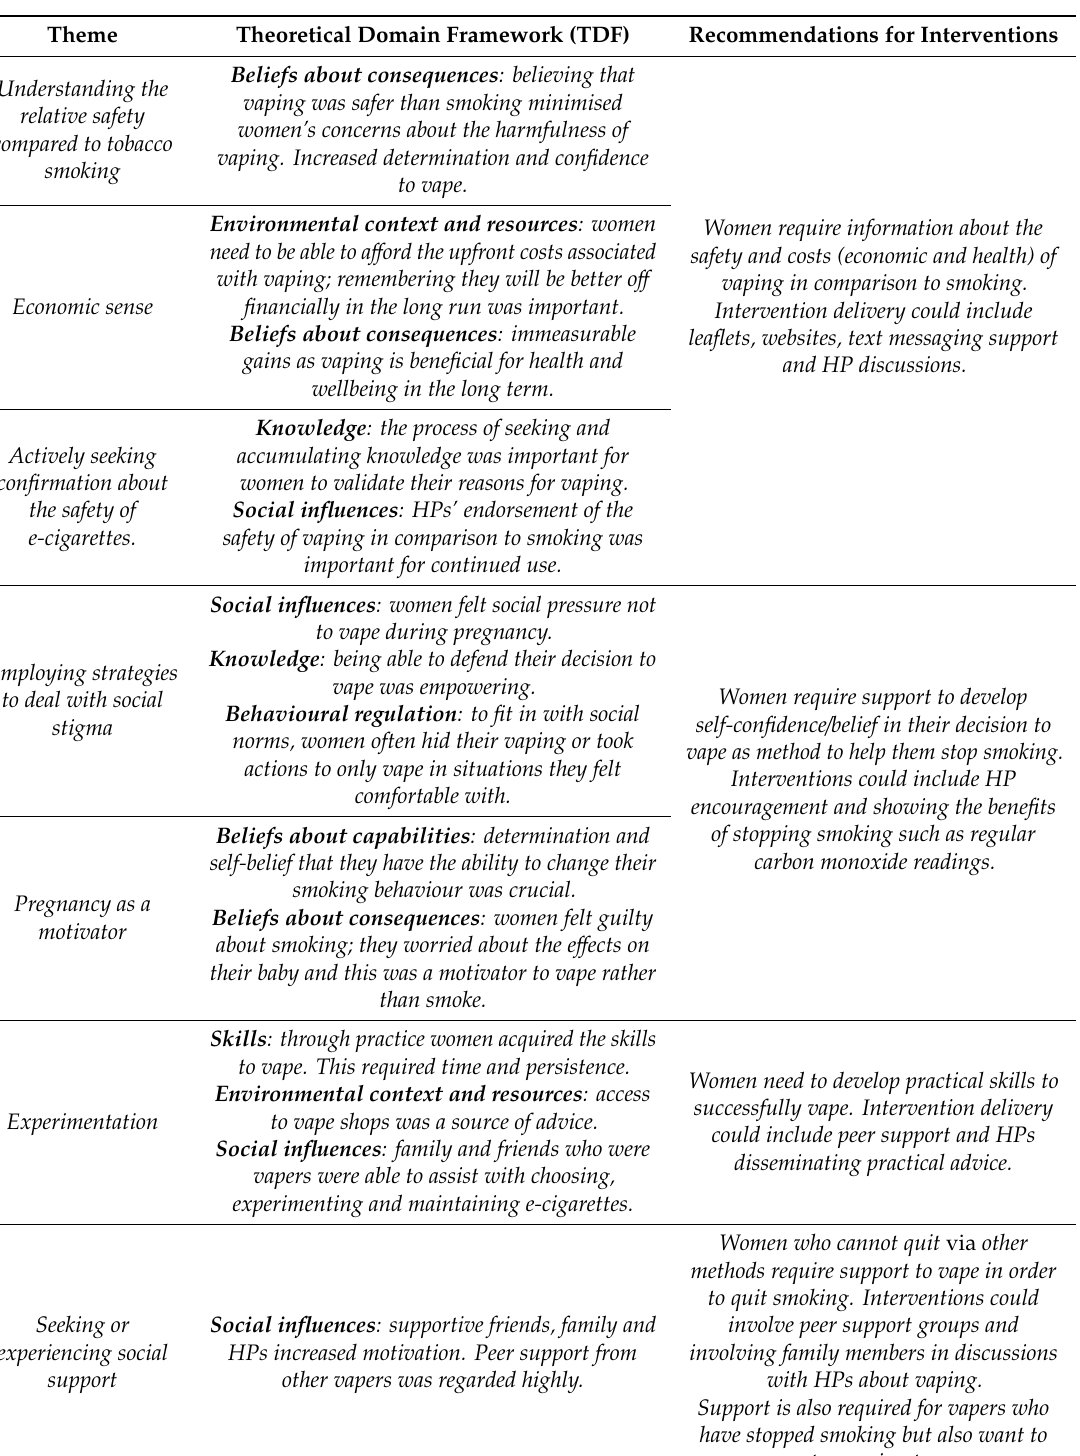
Table 2. Theoretical Domain Framework and the identified